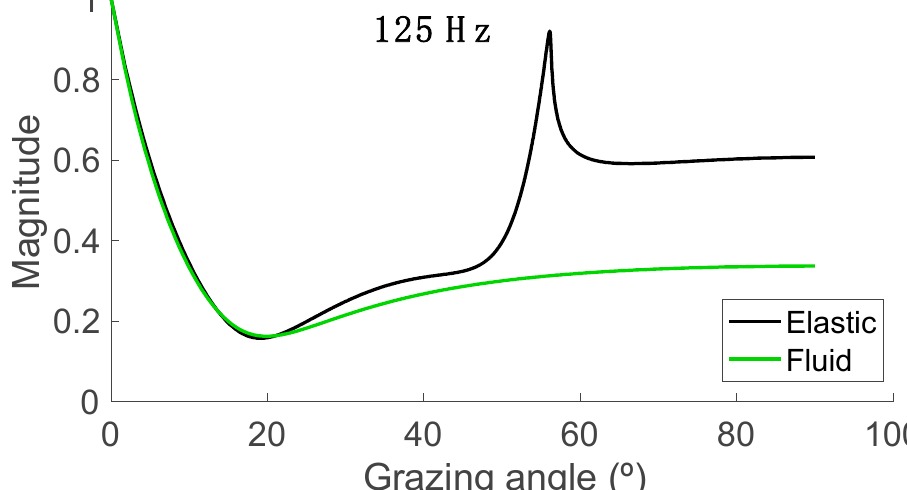
Figure 4. Example of the reflection coefficients of an elastic model (blue line) and a representative fluid model (green line) calculated with BOUNCE at 125 Hz.